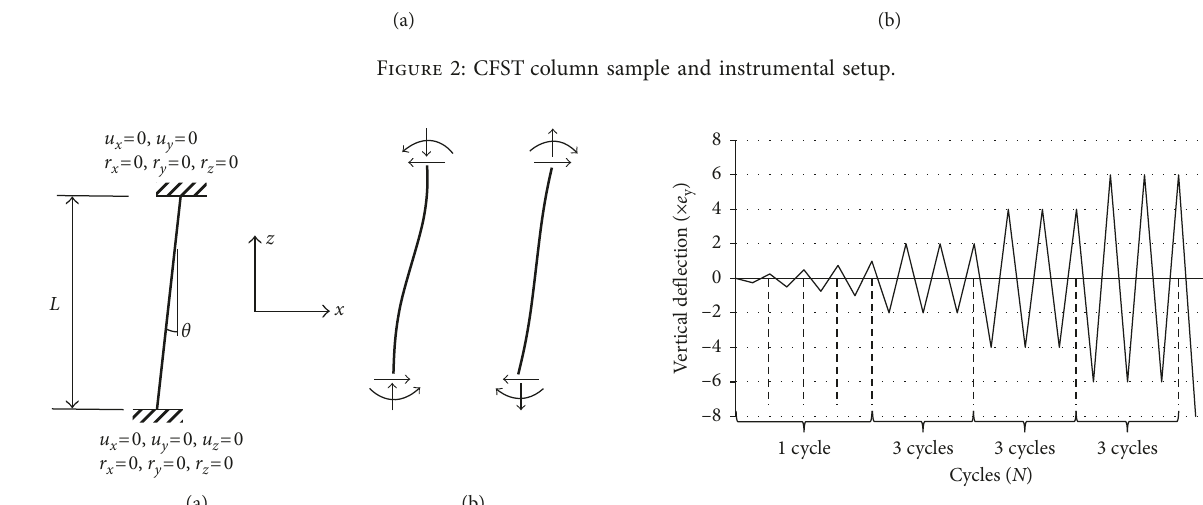
Figure 3: Boundary conditions and induced column forces.